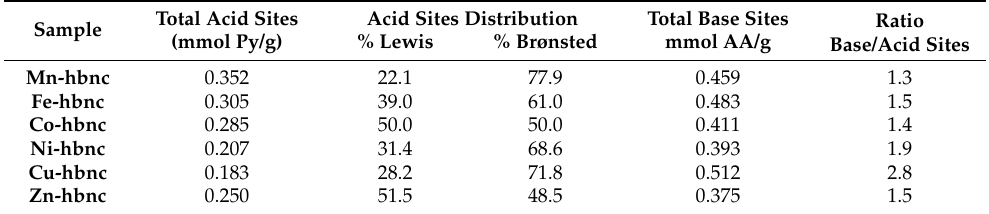
Table 6. Acid–base properties of the